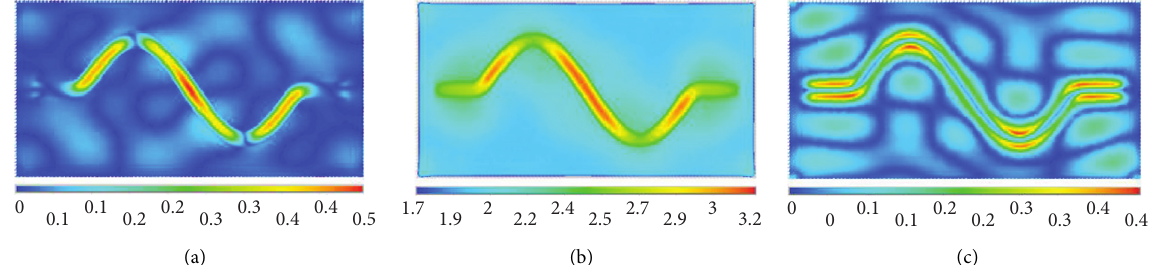
Figure 36: SH wave incident ( H � 125m, f � 1.0Hz, C